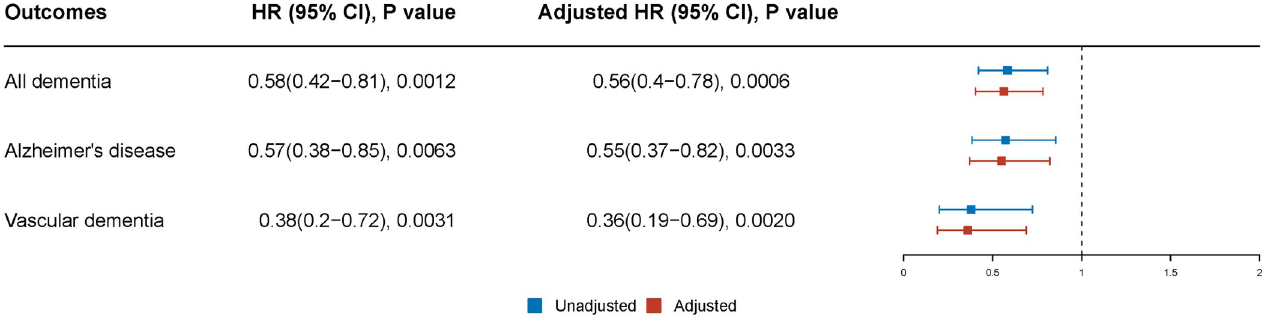
Fig 3. HRs, 95% CIs, and p -values for the association of lithium with the development of dementia (and its subtypes) by Cox proportional hazards models. HRs, 95% CIs, and p -values were extracted from inverse probability weighted Cox regression. Adjusted HRs were adjusted for age, sex, marital status, ethnicity, smoking status, alcohol disorders, antipsychotic use, depression, mania or BPAD, hypertension, central vascular disease, diabetes mellitus, and hyperlipidemias. The AIC was 14,275 for the model fitted for all dementias, 13,240 for the model fitted for AD, and 13,220 for the model fitted for VD. AD, Alzheimer disease; AIC, Akaike information criterion; BPAD, bipolar affective disorder/mania; CI, confidence interval; HR, hazard ratio; VD, vascular dementia.